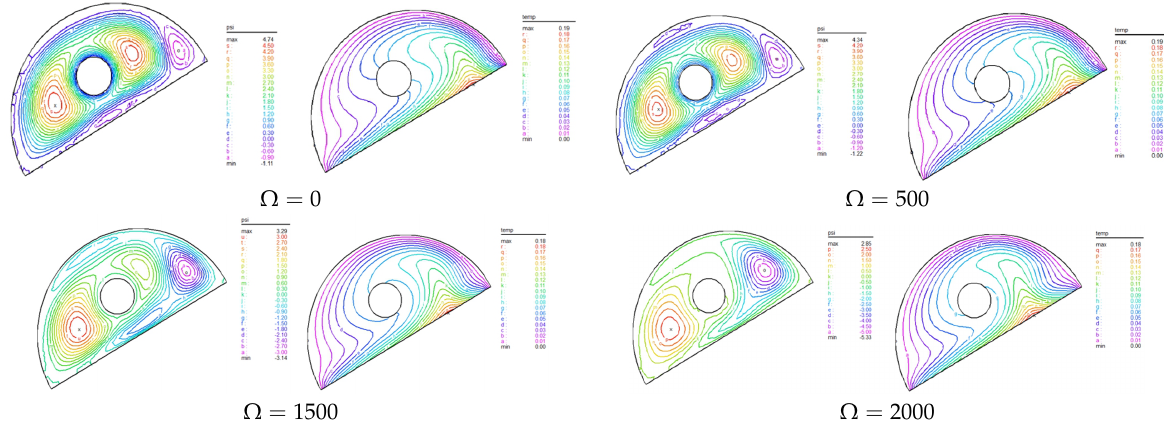
Fig. 6. Isotherms and streamlines for different angular velocity at γ = 30 ◦ ,C = 0.2, and Ra = 10 6